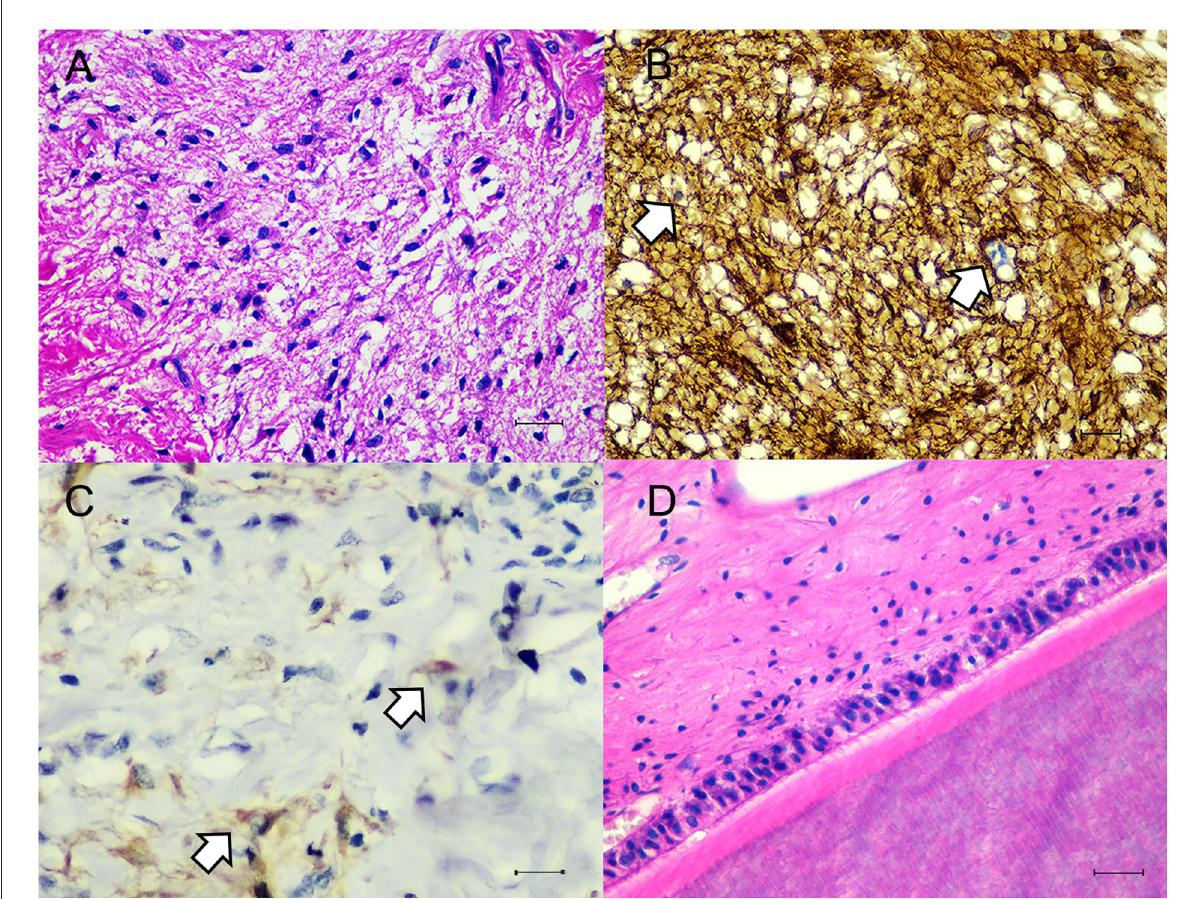
FIGURE2 Microscopic findings of ectodermal components. (A) The neuronal tissue was composed of many glial cells amid fibrillar to neuropil. H&E. Bar = 50 µ m. (B) Glial cells showed immunostaining with GFAP (white arrows). IHC. Bar = 50 µ m. (C) Neurons showed immunostaining with Neuron-n (white arrow). IHC. Bar = 50 µ m. (D) Area of tissue differentiation toward tooth characterized by large island of eosinophilic dentin and enamel with palisading layer of ameloblasts amid variably dense periodontal ligament stroma. H&E. Bar = 50 µ